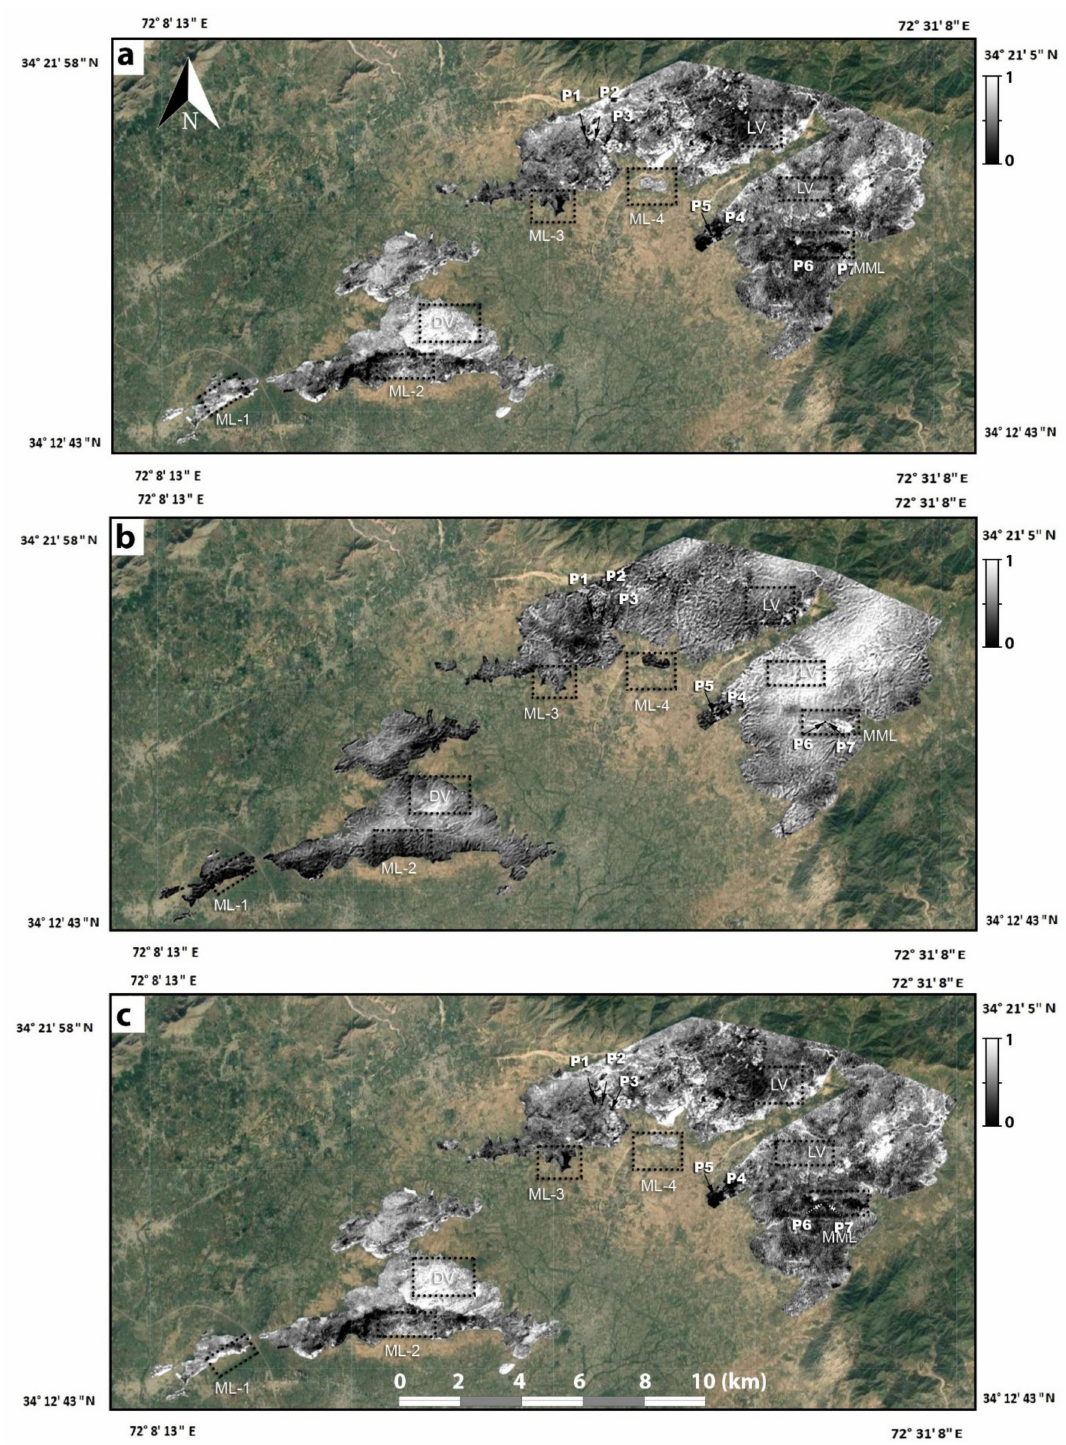
Figure 7. ( a ) Landsat-8 PC4 of the raw dataset showing granite as darker and medium-toned and marble shown in dark; ( b ) PC3 of the raw dataset showing marble and vegetation in brighter pixels and granite in dark; ( c ) PC3 of the stretched Landsat-8 data showing granite in dark to